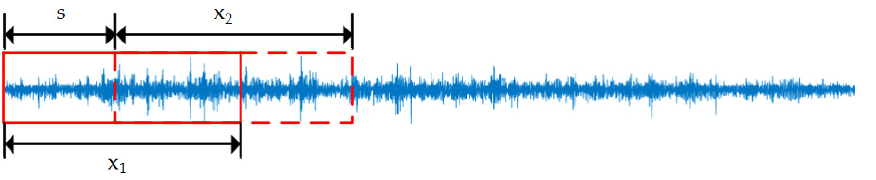
Figure 11. The overlap slicing method. After obtaining sufficient sample data, the sample data were normalized by